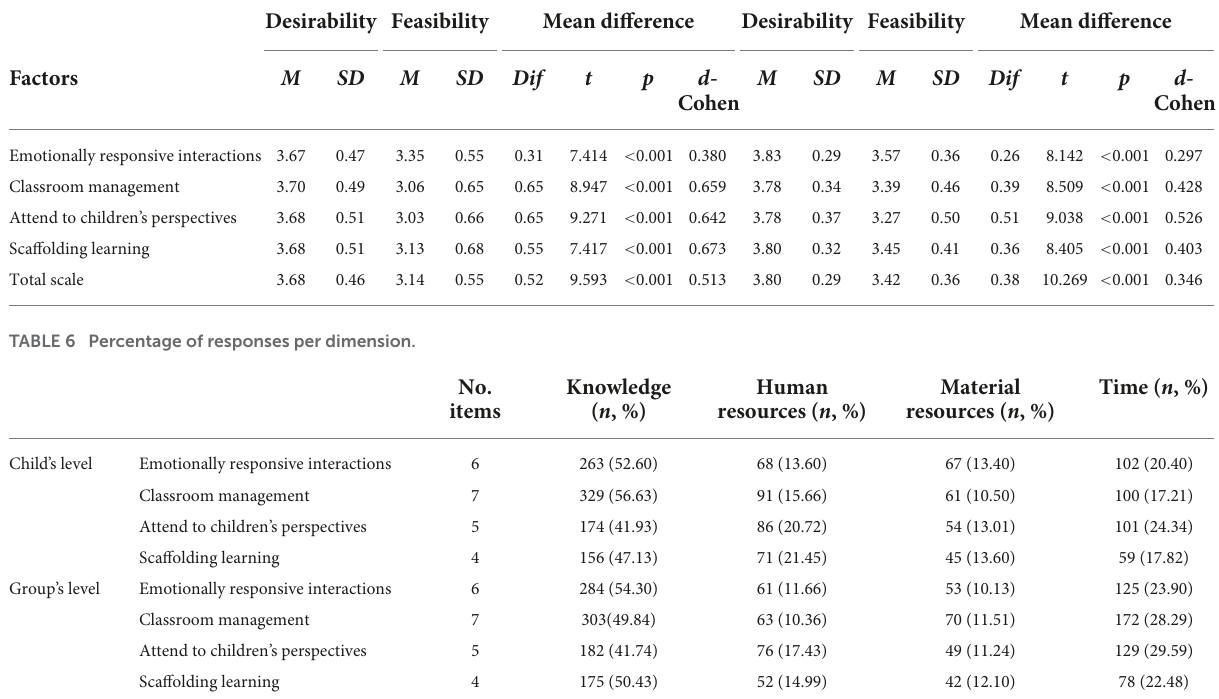
TABLE 5 Comparisons between ECEC teachers’ desirability and feasibility ratings for the four dimensions at the child and group levels. For the child For the group Desirability Feasibility Mean difference Desirability Feasibility Mean difference